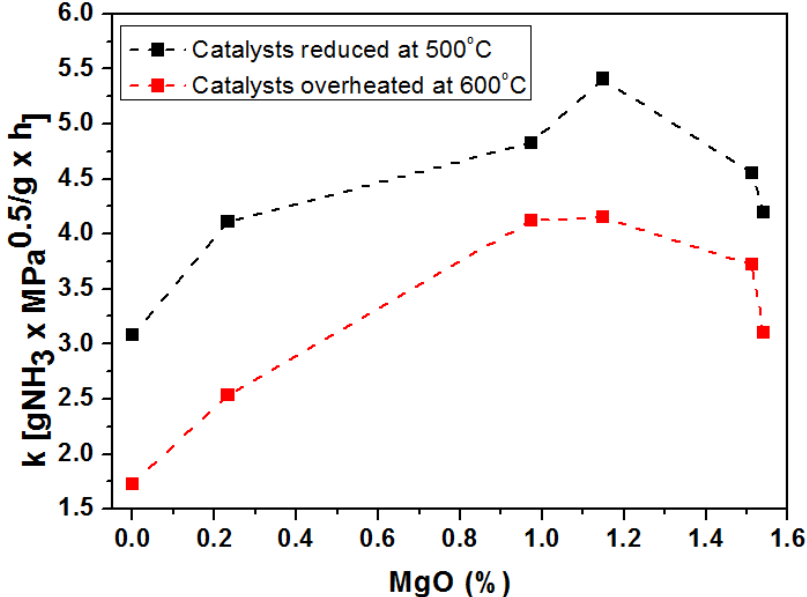
Figure 8. Dependence of the activity of the catalysts (k) measured at 450 °C on the amount of magnesium oxide in the precursors.